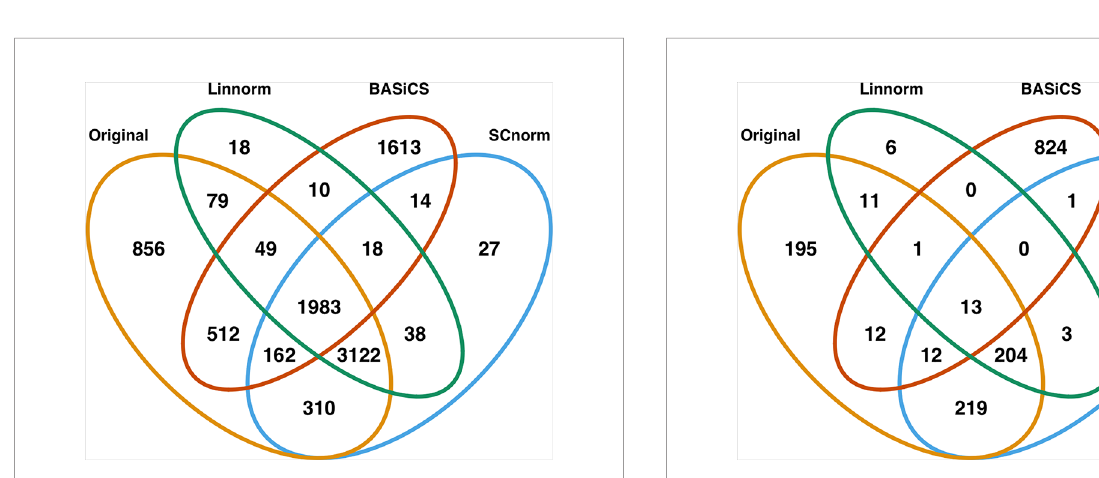
FIGURE 8 | Venn diagram of all DE genes detected at 0.05 signi fi cance level for the mouse embryonic dataset.